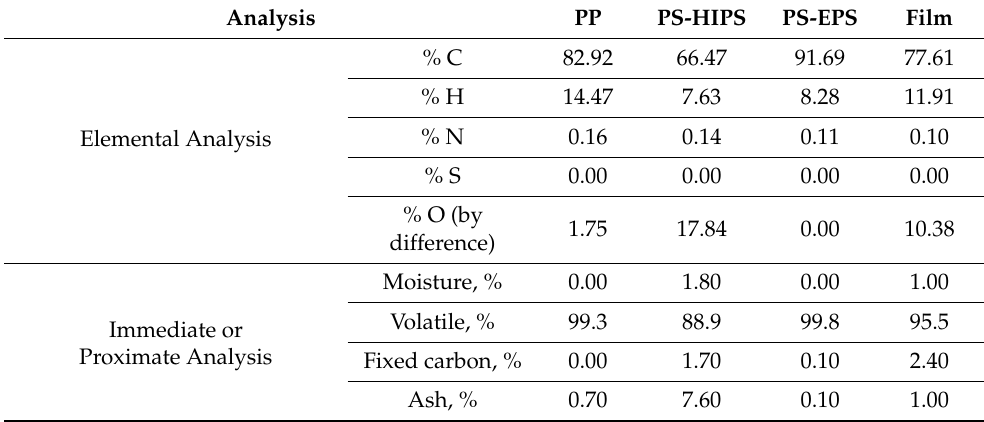
Table 2. Results of immediate and elemental analysis contained in the non-recyclable mixed plastics bales from municipal solid